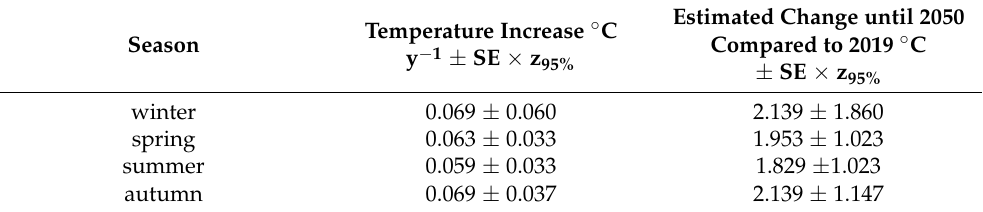
Standard error (SE) × z 95% indicates the 95% confidence and the estimated changes until 2050 compared to the mean temperature in 2019 are sum-